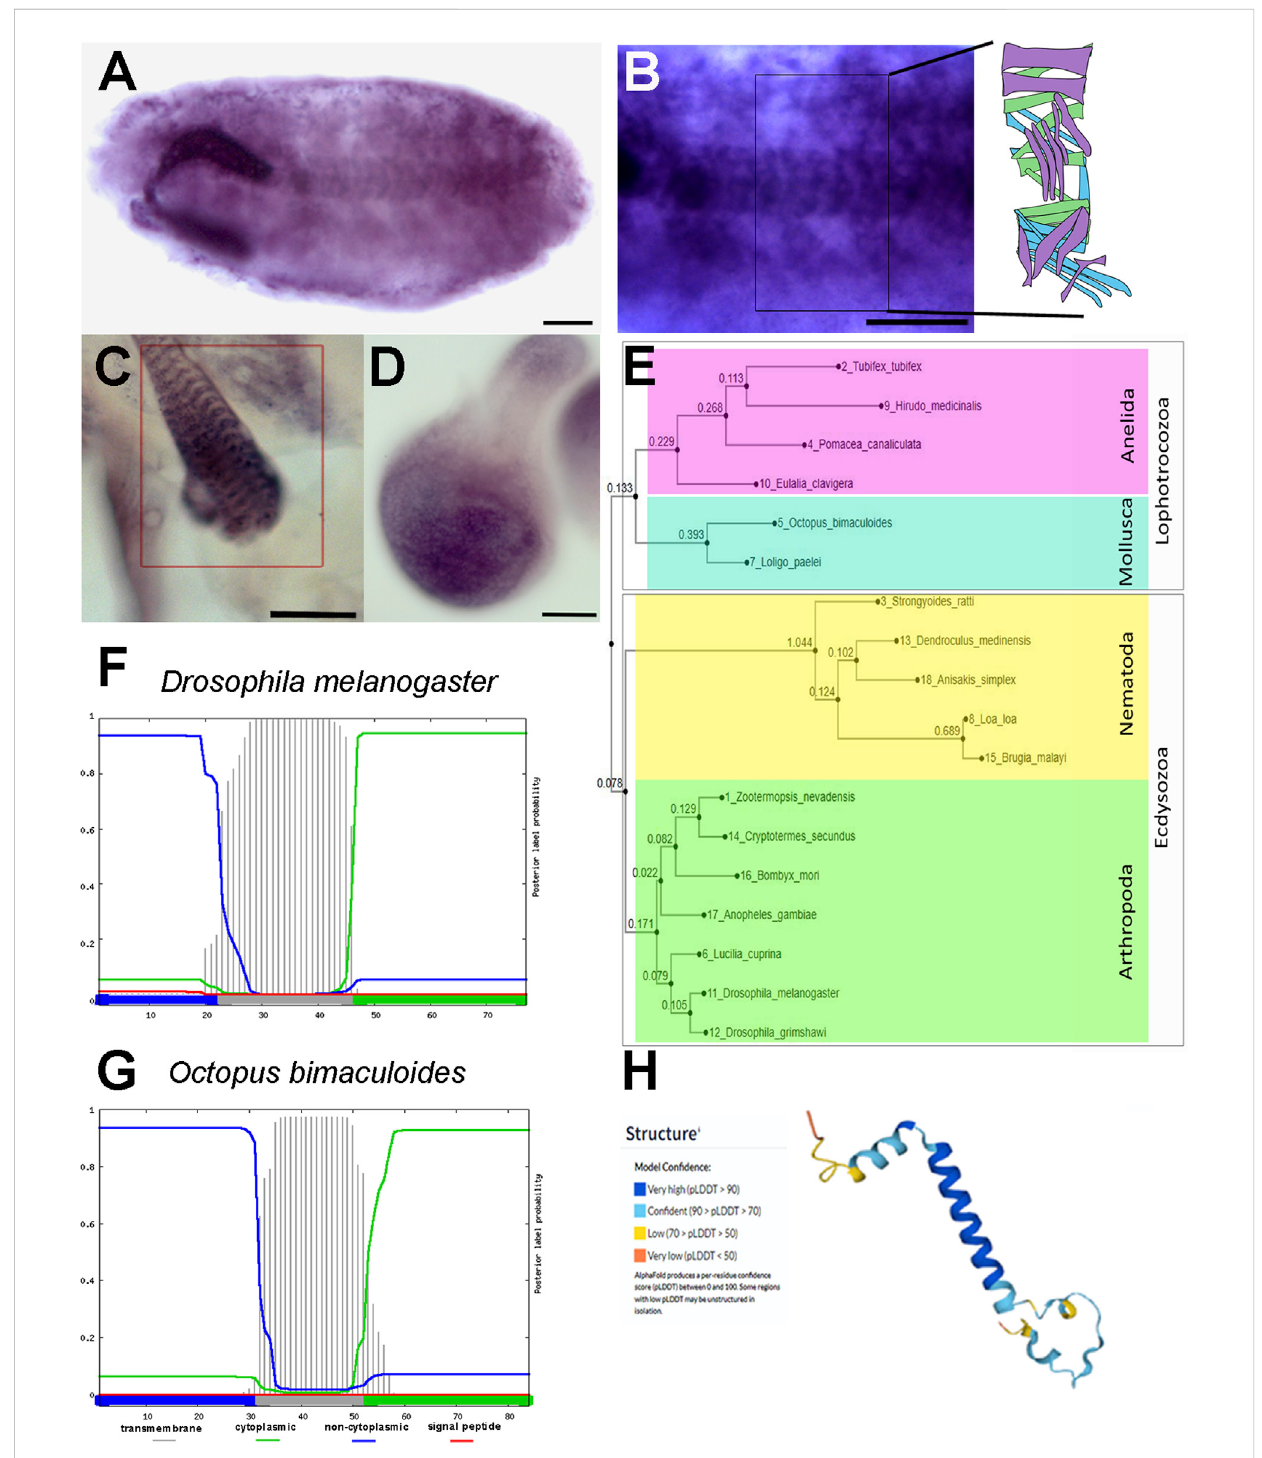
FIGURE 1 prto patternofexpression,anditsproteinsequenceandstructureconservation. (A – D) Insitu hybridisationusingdigoxigenin-labelled prto probe. (A) Stage 17 embryo showing labelling in the somatic muscles. (B) High magni fi cation of B showing the stereotypical array of somatic muscles per hemisegment as shown in diagram in inset. (C) L3 larval somatic muscle showing prto mRNA expression in the sarcolemma (rectangle). (D) prto mRNA expression in the pouch of the 96hr AEL wing imaginal disc. (E) Neighbor-Joining phylogenetic tree showing the evolutionary distances of Prto peptides across Protostomes. (F,G) Secondary structure predictions of signal peptide and transmembrane domains in Prto peptides by Phobius program from Drosophila melanogaster (F) and Octopus bimaculoides (G) showing a conserved single transmembrane topology (grey bars). (H) 3D predicted structure of Drosophila Prto peptide using the Alphafold program, displaying in blue very high con fi dence of helical structure. Scale bars denote 50